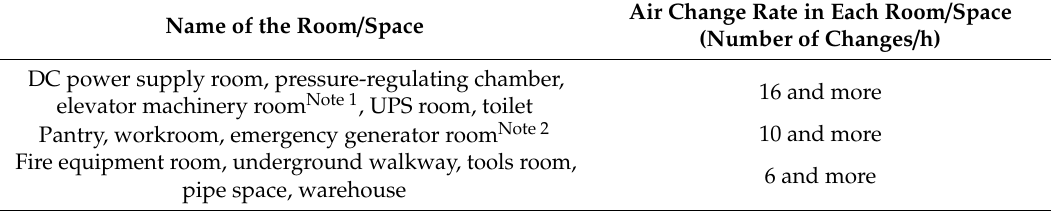
Table 1. Rate of air changes in each room /